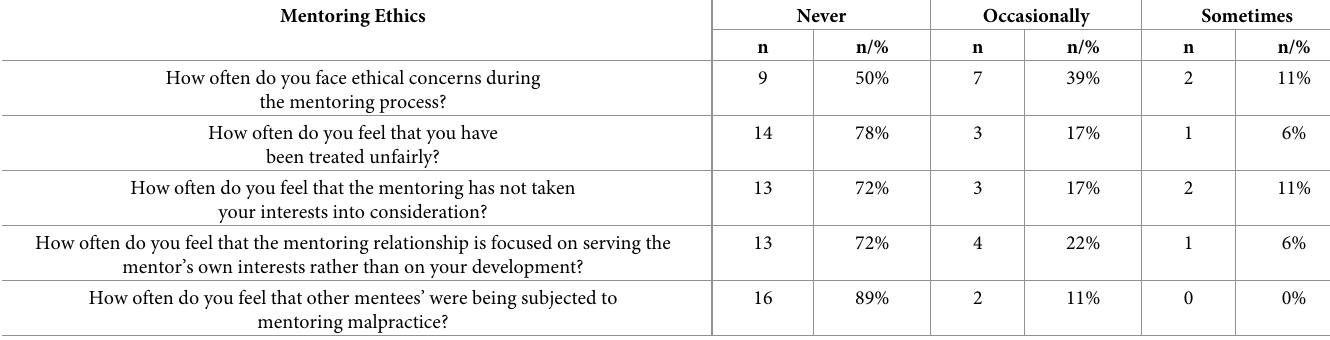
Table 12. Mentoring